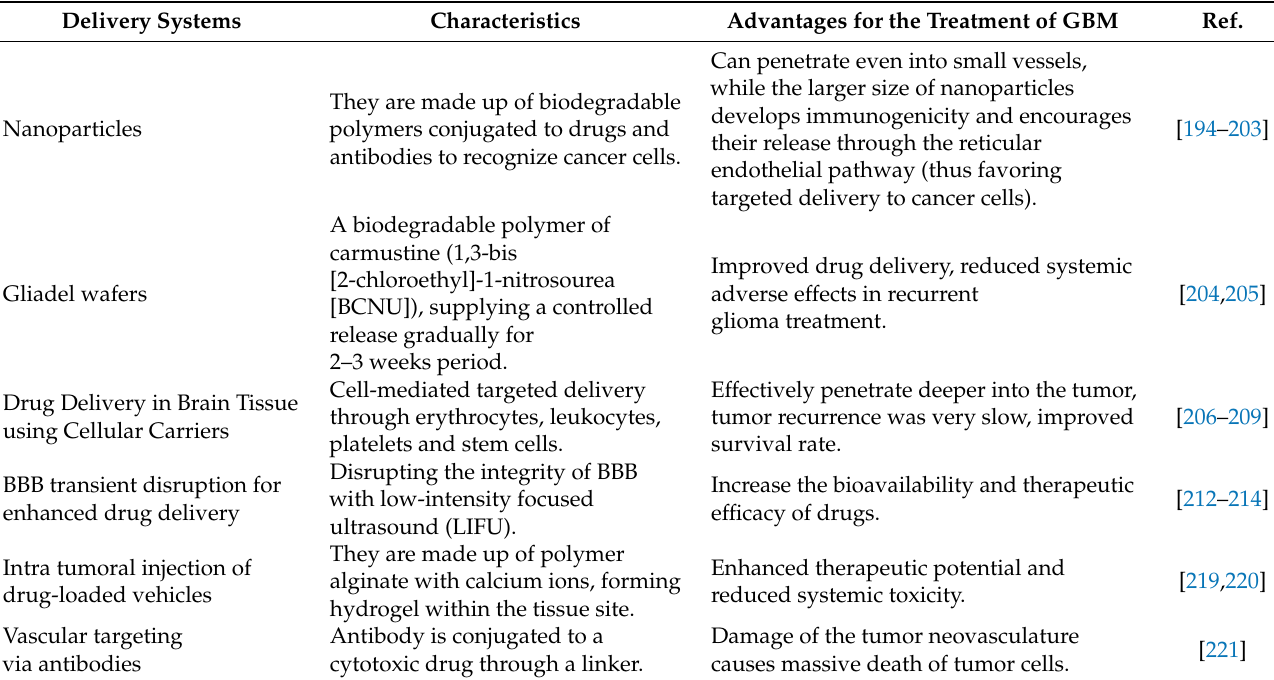
Table 2. Drug delivery system targeting